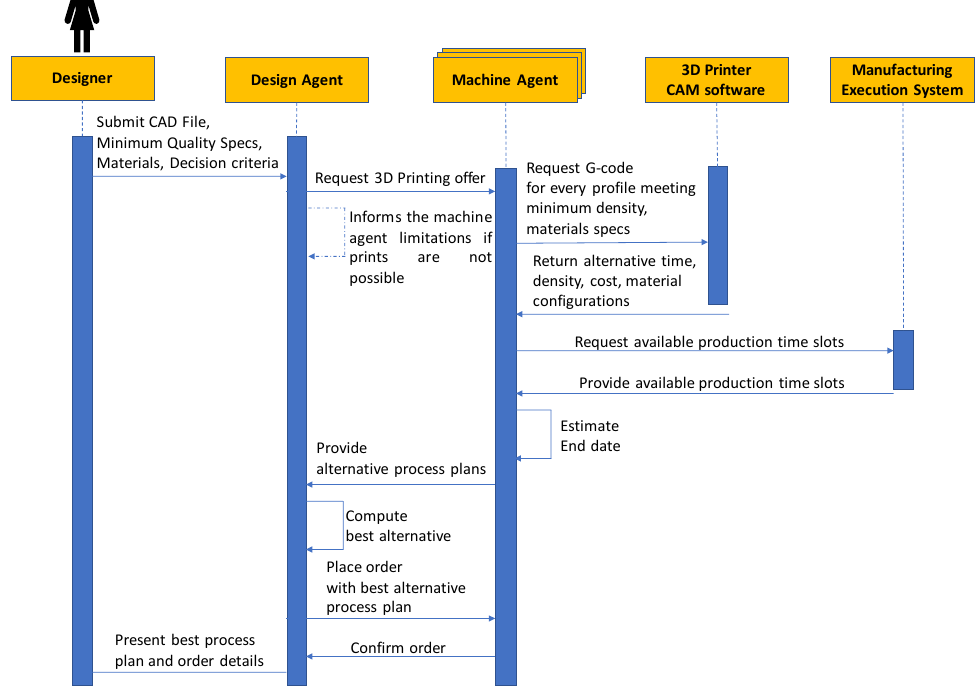
Figure 4. UML Sequence diagram showing the interaction among agents and platform components.